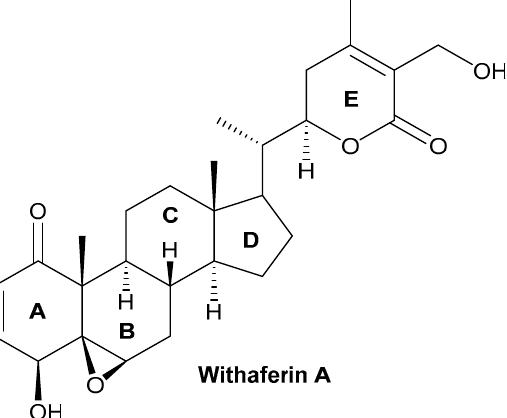
Figure 1. Chemical structure of withaferin A.